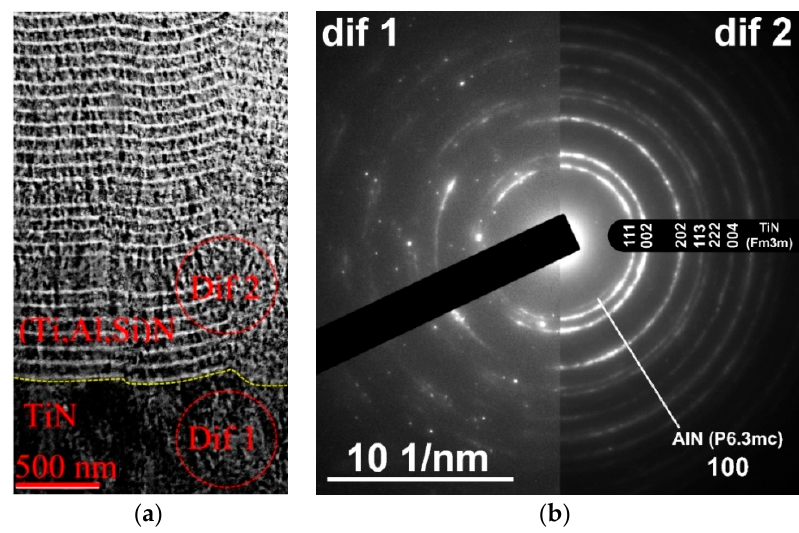
Figure 9. Localization of the studied areas ( a ) and selected area electron diffraction patterns ( b ) of the wear-resistant (Ti,Al,Si)N layer (Dif 1) and the transition TiN layer (Dif 2) of the coating (sample S4).